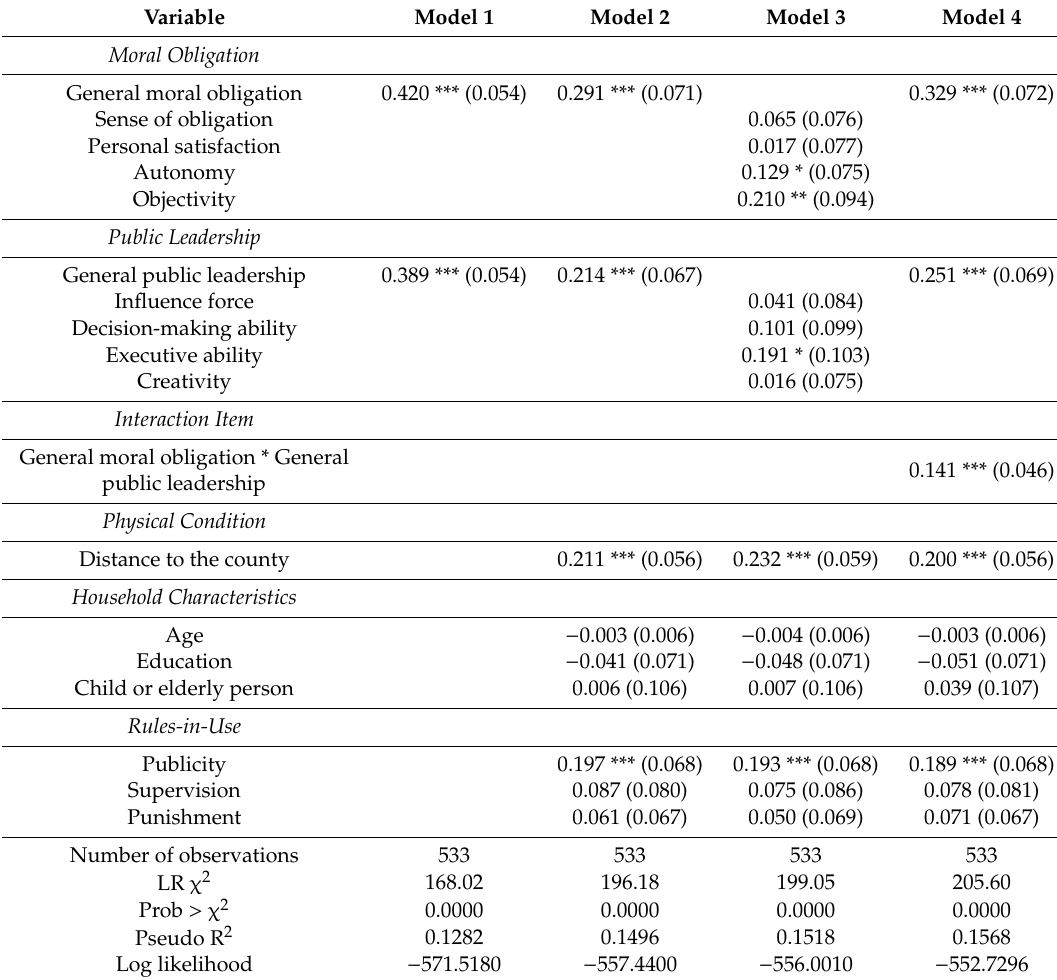
Table 4. The e ff ects of moral obligation and public leadership on villagers’ going out